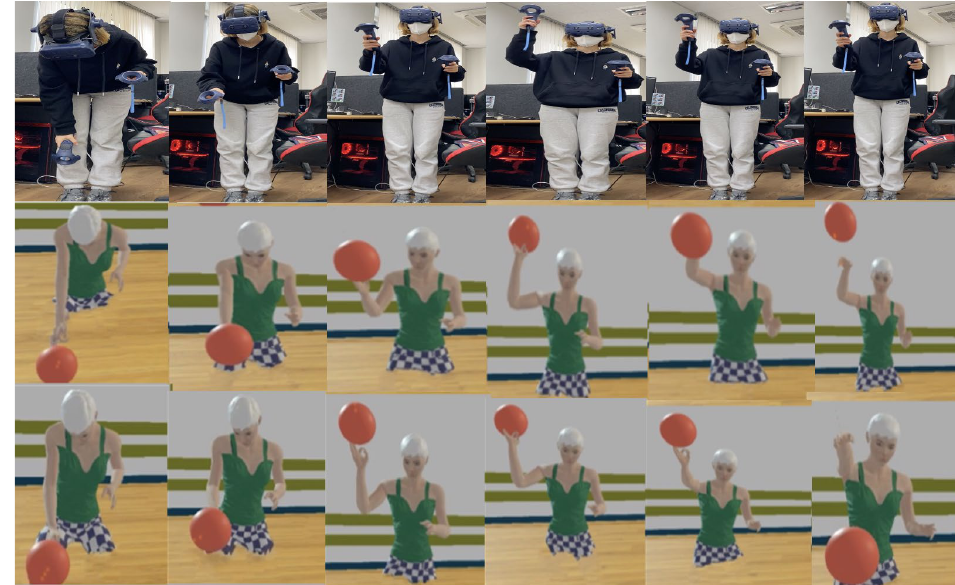
Figure 8. Comparison of our results ( middle ) and IK results ( bottom ) from the user ( top ).